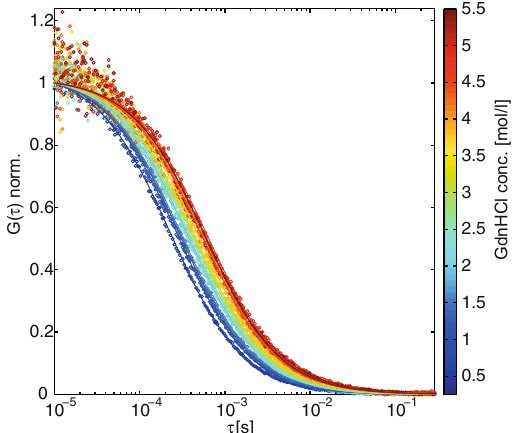
Figure 1. Normalized correlation curves ( ○ ) with their corresponding best-fit lines ( − ) of AF488-C(0)A β 42 under denaturing conditions of increasing GdnHCl concentrations and based on a one-component diffusion model (equation (S1) in the Supplementary Information). The shift towards larger correlation times can mainly be attributed to (i) the increasing viscosity of the GdnHCl solutions and (ii) an increase of the hydrodynamic radius due to the unfolding process.